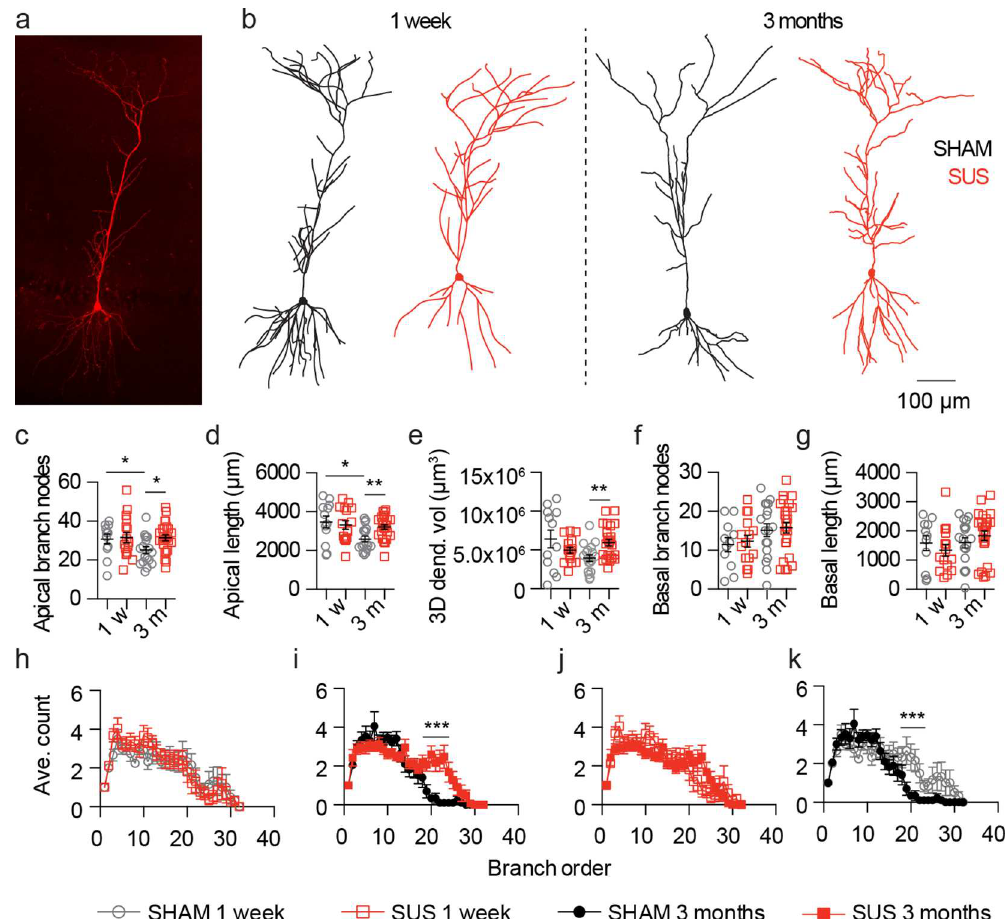
Fig 4. Multiple SUS treatments prevent dendrite loss of CA1 pyramidal neurons. (a) Fluorescent z-projection of a recovered fluorescently labeledneuron used for morphometric analysis. (b) Representative 2D projectionof 3D reconstructions of recorded neuronsfrom SUS- and sham-treated mice. (c-g) Quantification of (c) the number of apical dendrite branch nodes (SUS versus sham 1 w, p = 0.88, SUS 31.6 ± 2.71 nodes, sham 30.8 ± 2.43